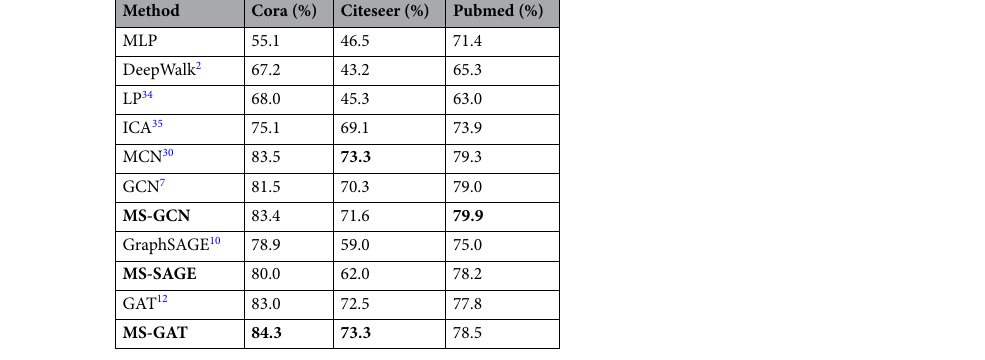
Table 4. Summary of results in terms of classification accuracies (citation